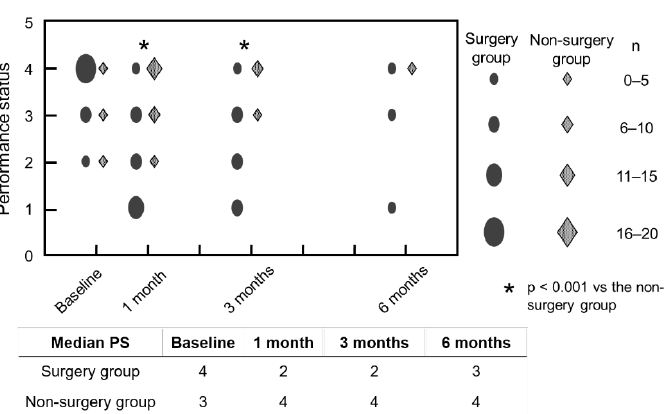
( p < 0.001 versus the non-surgery group at 1 and 3 months) but decreased at 6 months ( p = 0.057 versus the non-surgery group) (Figure 4).